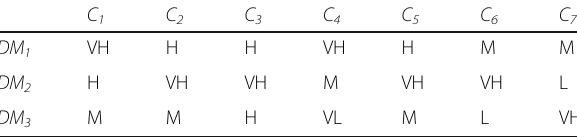
Table 1 Importance weight of criteria assessed by decision